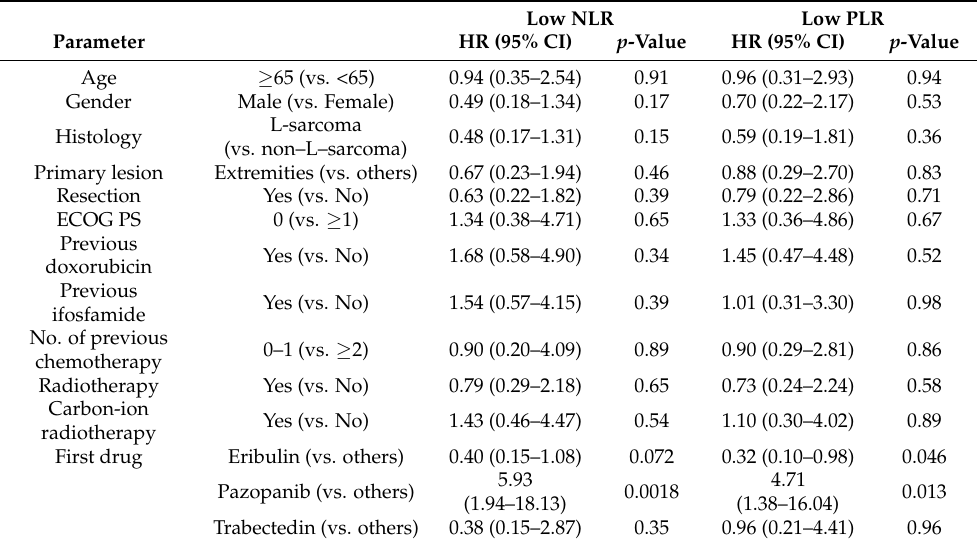
Table 3. Univariate analyses for OS in the low NLR and the low PLR subgroup.